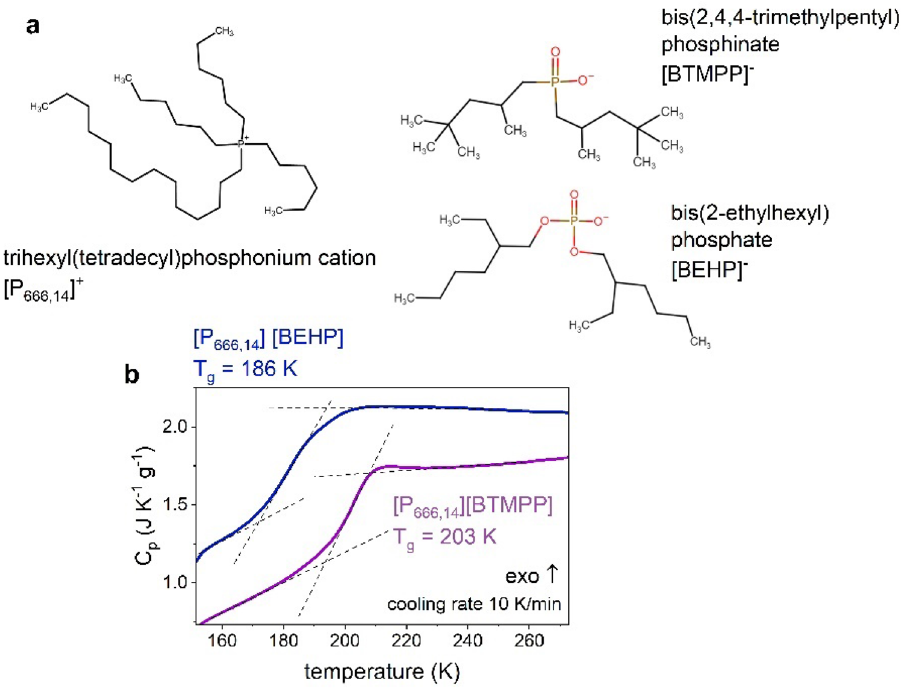
Figure 1. Initial characterization of studied ILs. ( a ) Chemical structure of trihexyl(tetradecyl)phosphonium cation